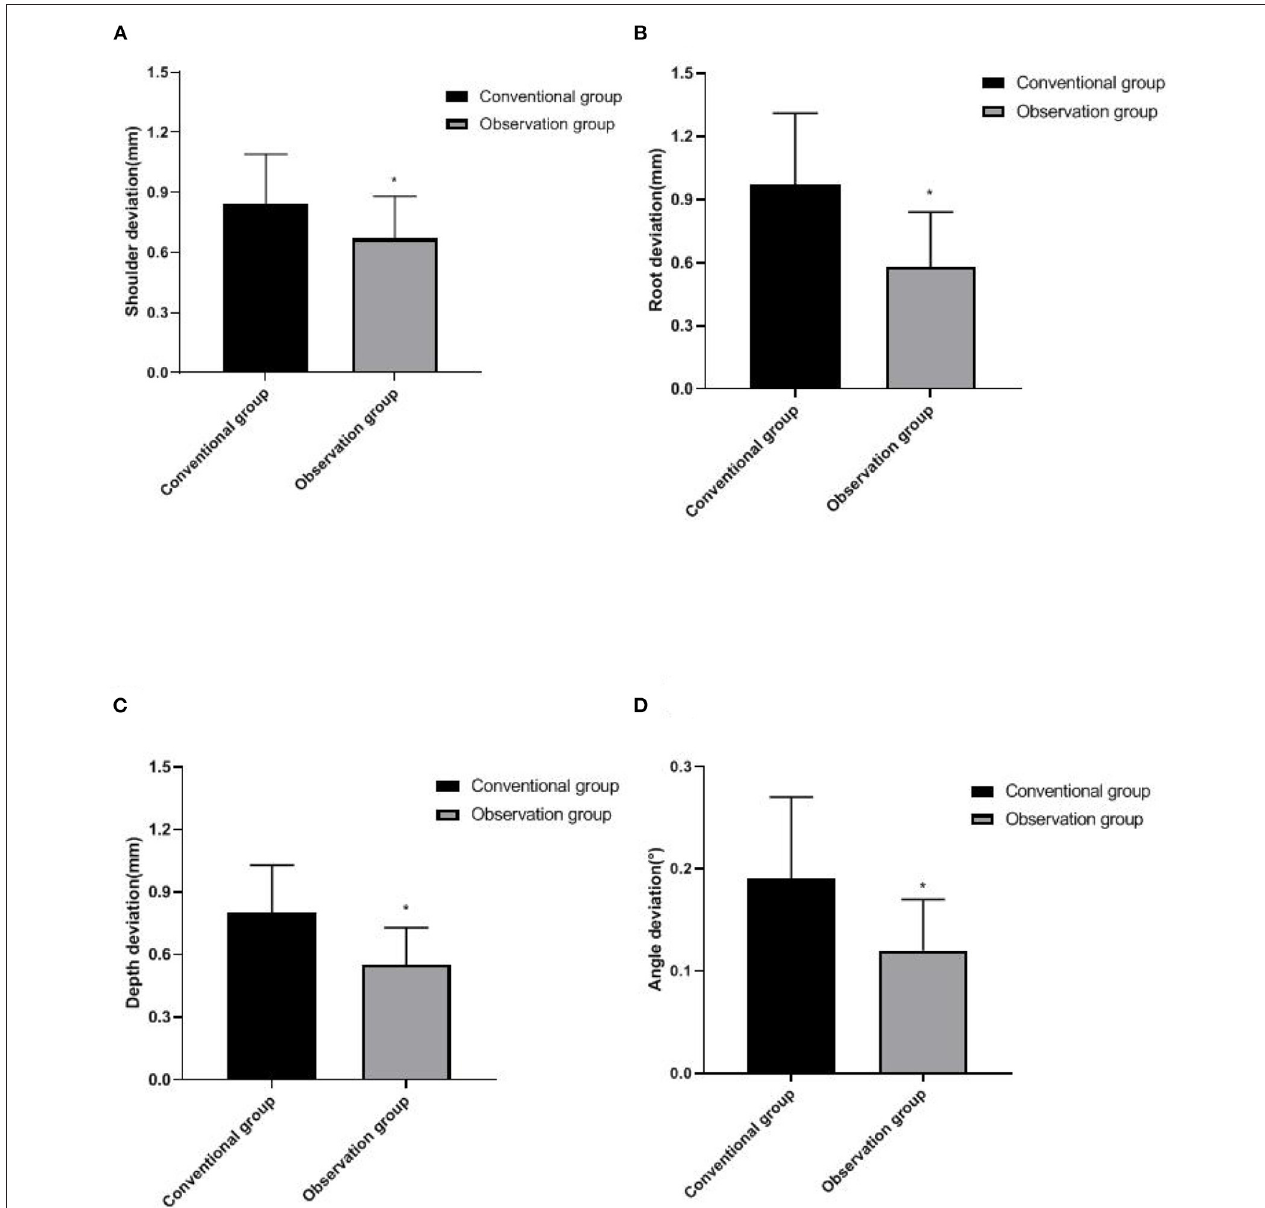
FIGURE 2 | Comparison of implant deviation between two groups. (A) Shoulder deviation, (B) Root deviation, (C) Depth deviation, and (D) Angle deviation. Compared with the conventional group, * p <